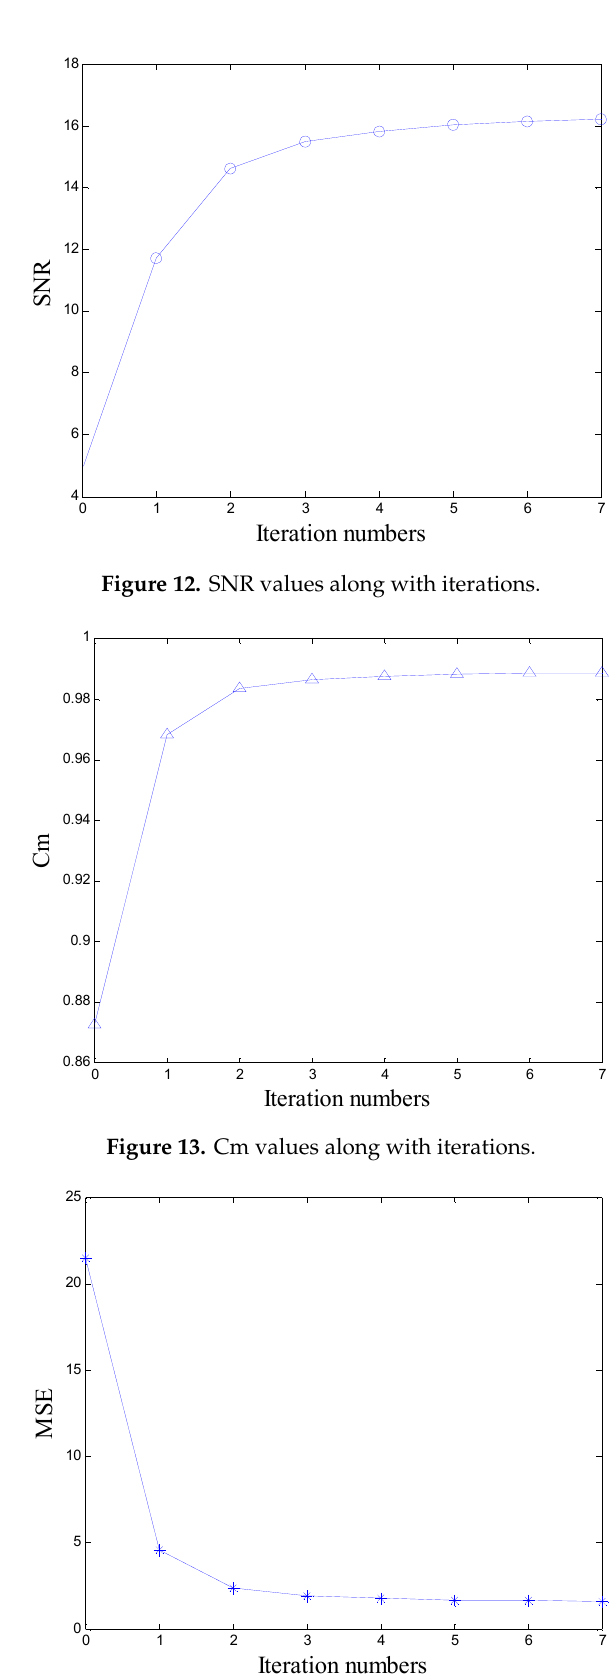
Figure 14. MSE values along with iterations.